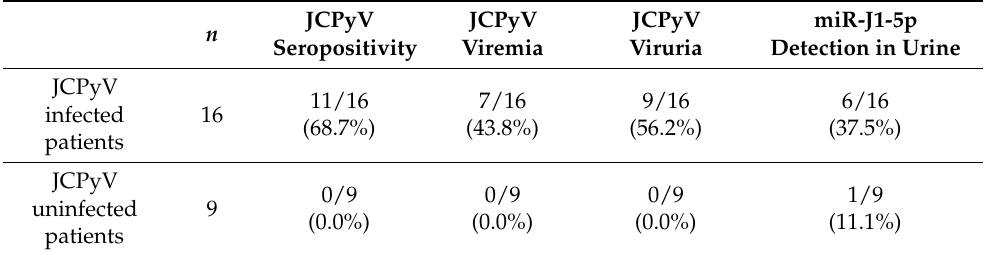
Table 1. JCPyV characterization in the enrolled